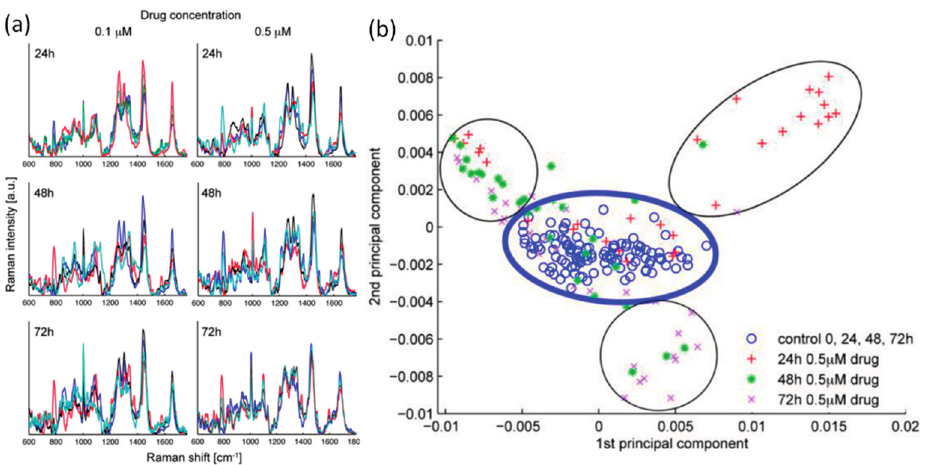
Figure 15. ( a ) Raman spectra recorded from leukemic T lymphocytes exposed to varying doses of a chemotherapy drug over time; ( b ) Principal component analysis revealed three stages in the apoptosis process induced by the drug [8] (Fair Use according to